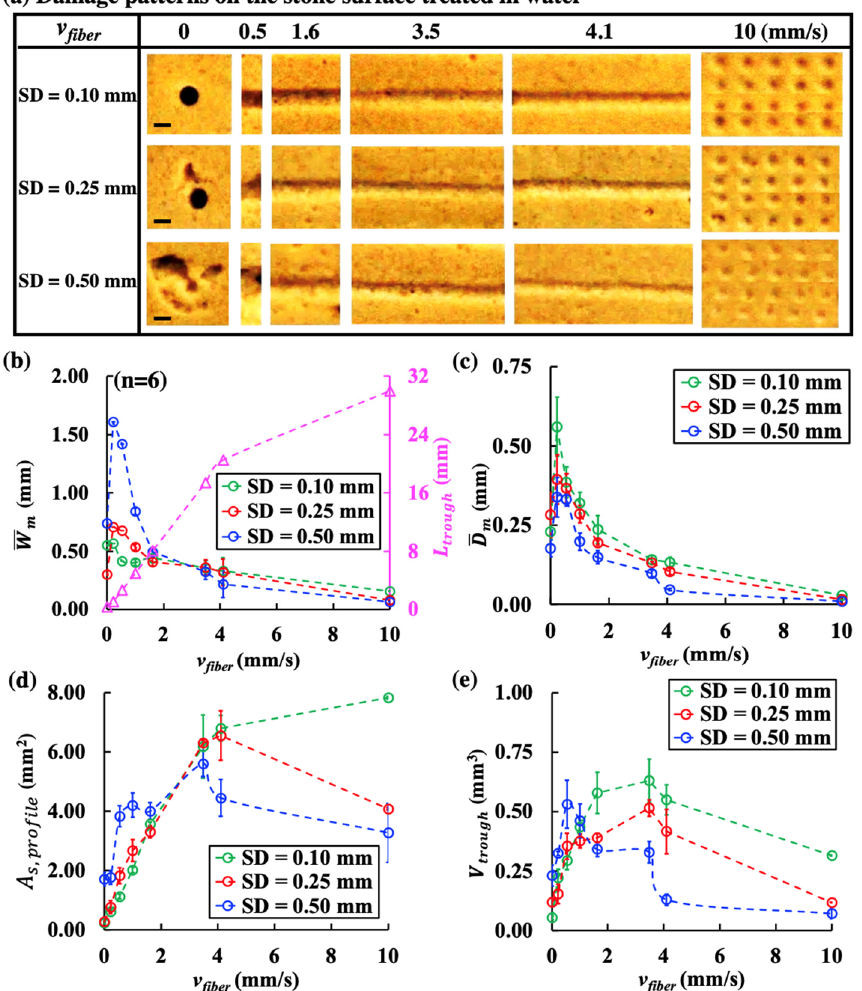
Figure 2. Different damage patterns and characteristic dimensions of the trough produced in water by 100 pulses (0.2 J and 20 Hz) during scanning treatment at various fiber speeds ( v fiber ). ( a ) Damage craters produced by the stationary fiber ( v fiber = 0 mm/s) and one-fifth of the damage troughs created at different v fiber under SD = 0.10, 0.25, and 0.50 mm (scale bar = 0.5 mm), ( b ) mean trough width ( W m ) (small circles in different colors) and total trough length ( L trough ) (small purple triangles), ( c ) mean trough depth ( D m ), ( d ) surface profile area ( A s, profile ), and ( e ) trough volume ( V trough ) quantified by OCT imaging analysis and plotted vs. v fiber .